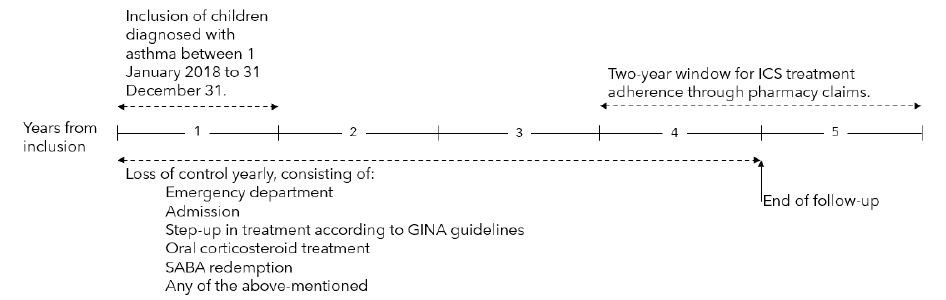
Figure 1. Timeline of the